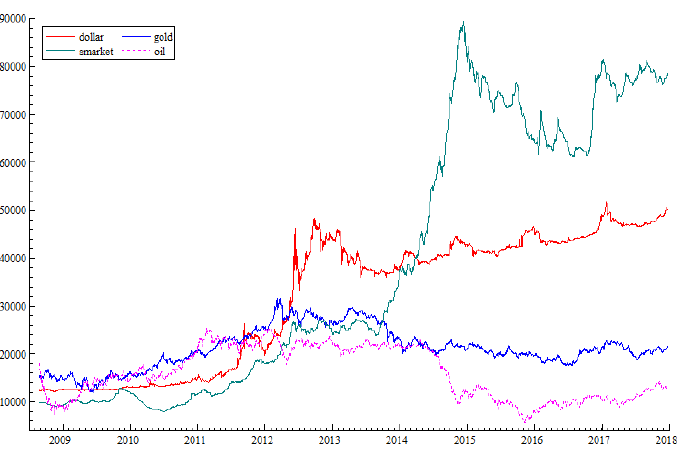
Figure 1. The level of